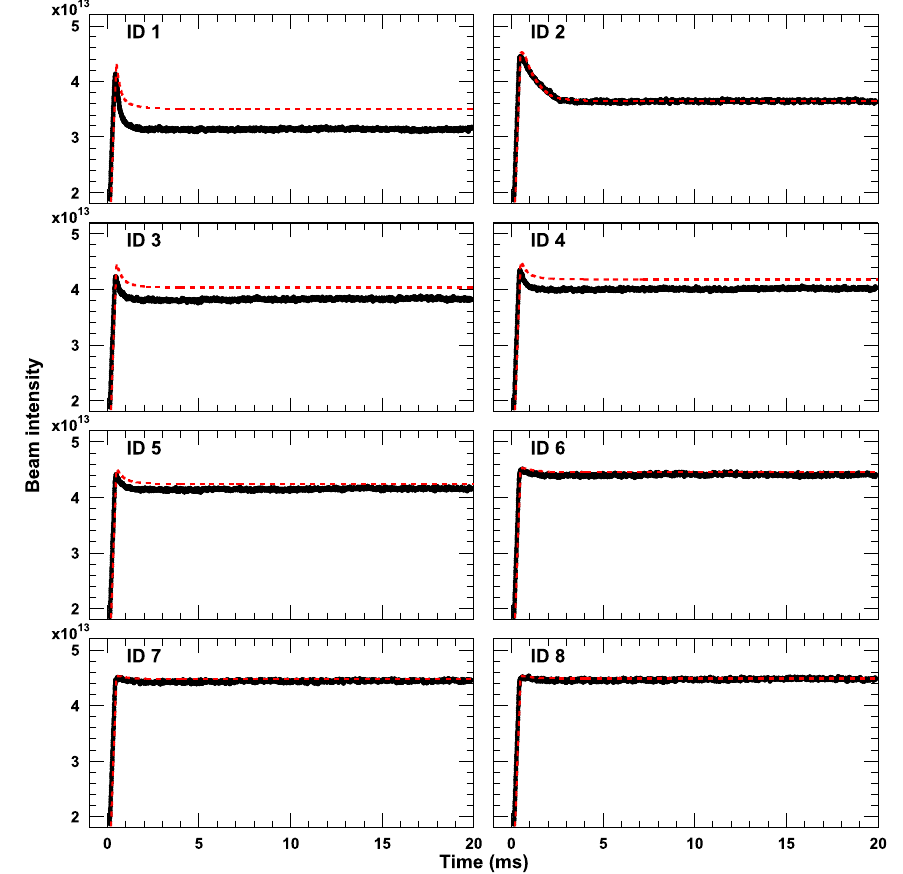
FIG. 10. Time dependence of the circulating beam intensity from injection through extraction, measured with the systematic combinations of transverse and longitudinal injection painting of IDs 1 – 8 in Table II, where the dashed red curves show the corresponding numerical simulation results.